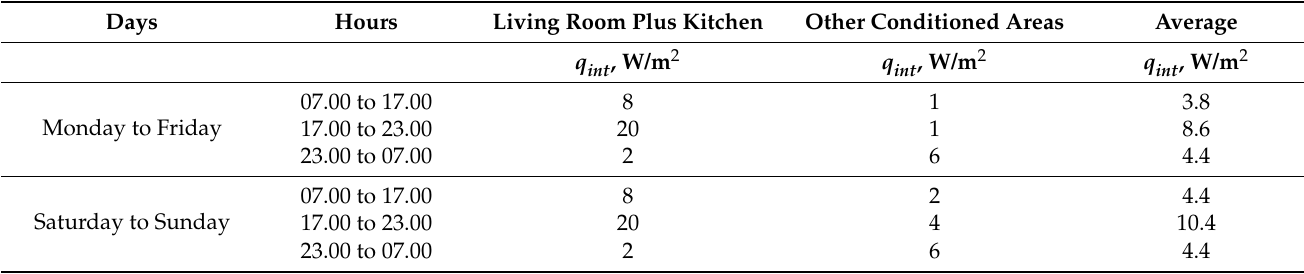
Table 3. Internal gains, determined based on